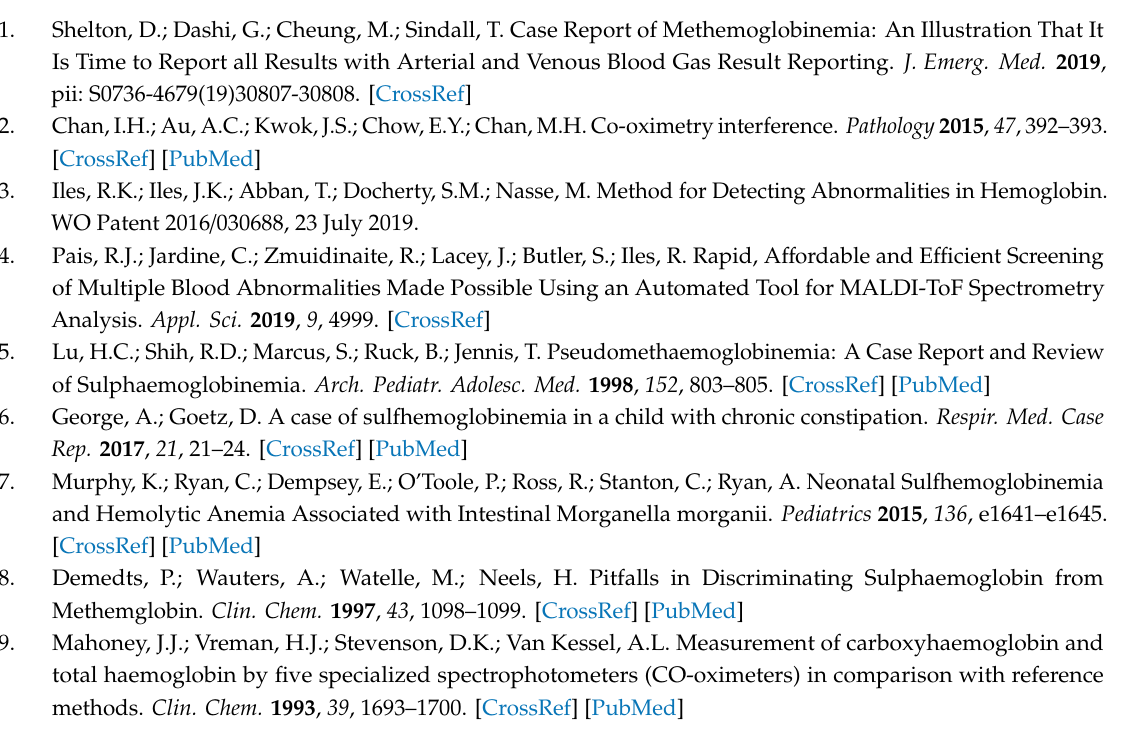
Figure S1: Patient blood sample profile at